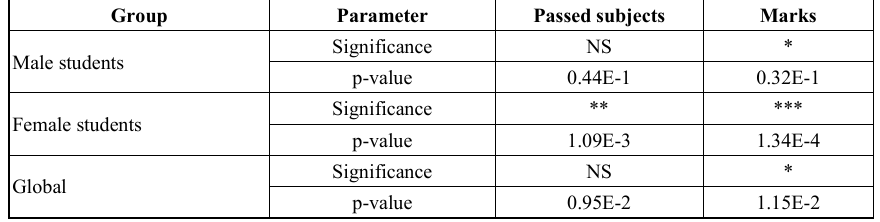
Table 8. Academic results comparison: gender gap evolution (2019-2020)